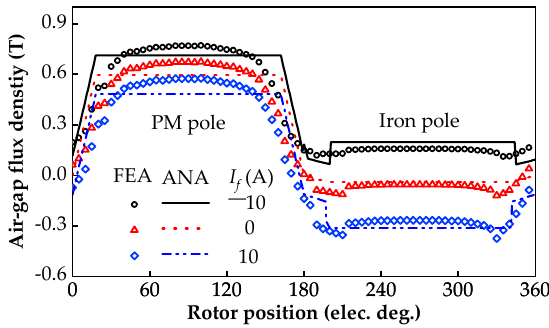
Figure 6. No-load air-gap magnetic flux density distributions.